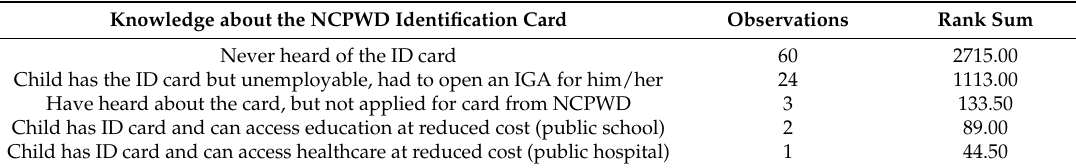
Table 2. Knowledge about the NCPWD ID card by parents of children with DDs.